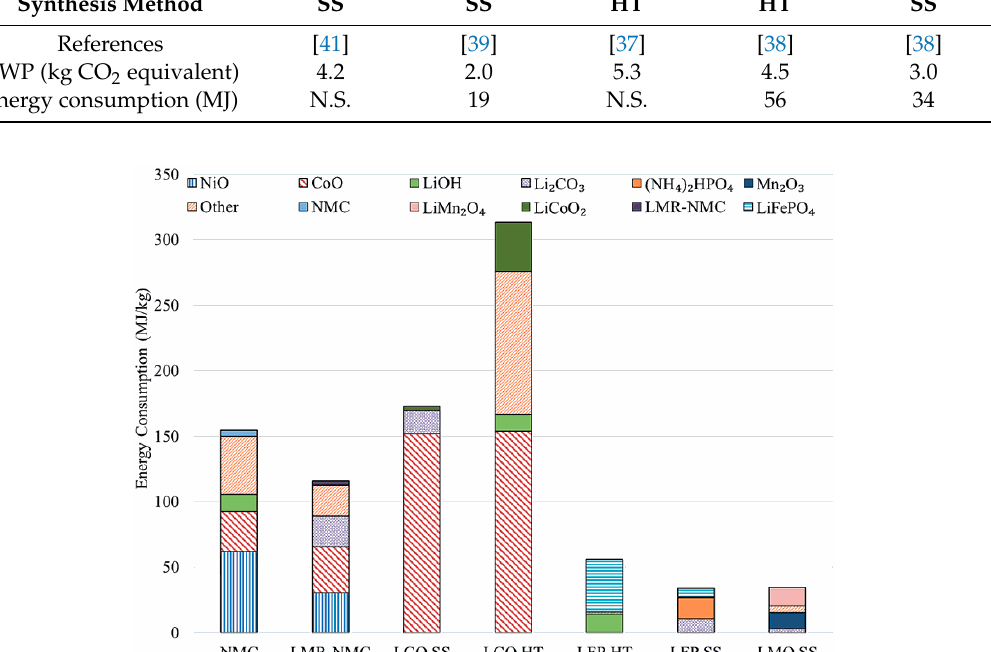
Figure 3. Energy consumption for different synthesis methods and various active materials (reproduced with permission from The Royal Society of Chemistry Ref. [38]); here, NMC, LMR-NMC, LCO, and LFP are lithium-nickel-manganese-cobalt oxide, Li and Mn-rich lithium-nickel-manganese-cobalt oxide, lithium-cobalt oxide, and lithium-iron phosphate, respectively; and SS and HT are solid state and hydrothermal synthesis methods.